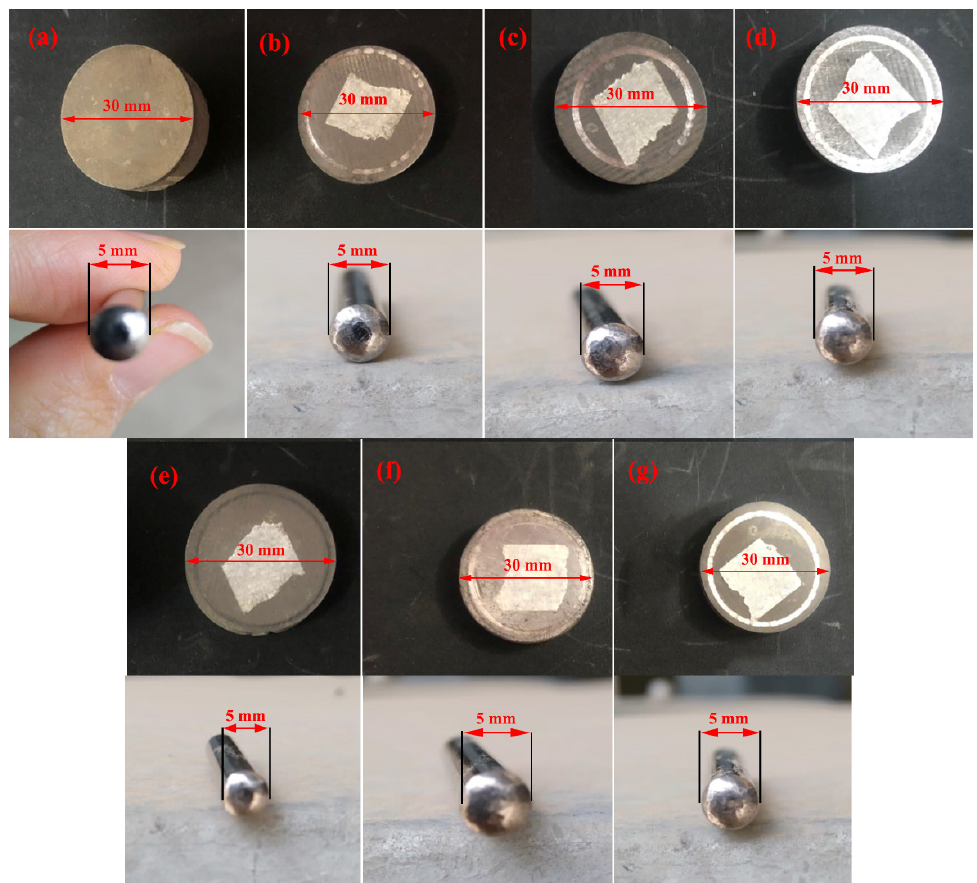
Figure 1. Image of the samples and pins: ( a ) before wear test, ( b ) worn surface of sample 1, ( c ) worn surface of sample 2, ( d ) worn surface of sample 3, ( e ) worn surface of sample 4, ( f ) worn surface of sample 5, and ( g ) worn surface of sample 6.